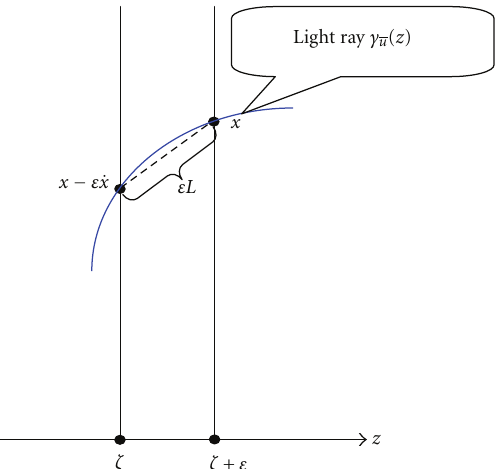
Figure 7: Thin layer of an optically quasi-homogeneous medium.